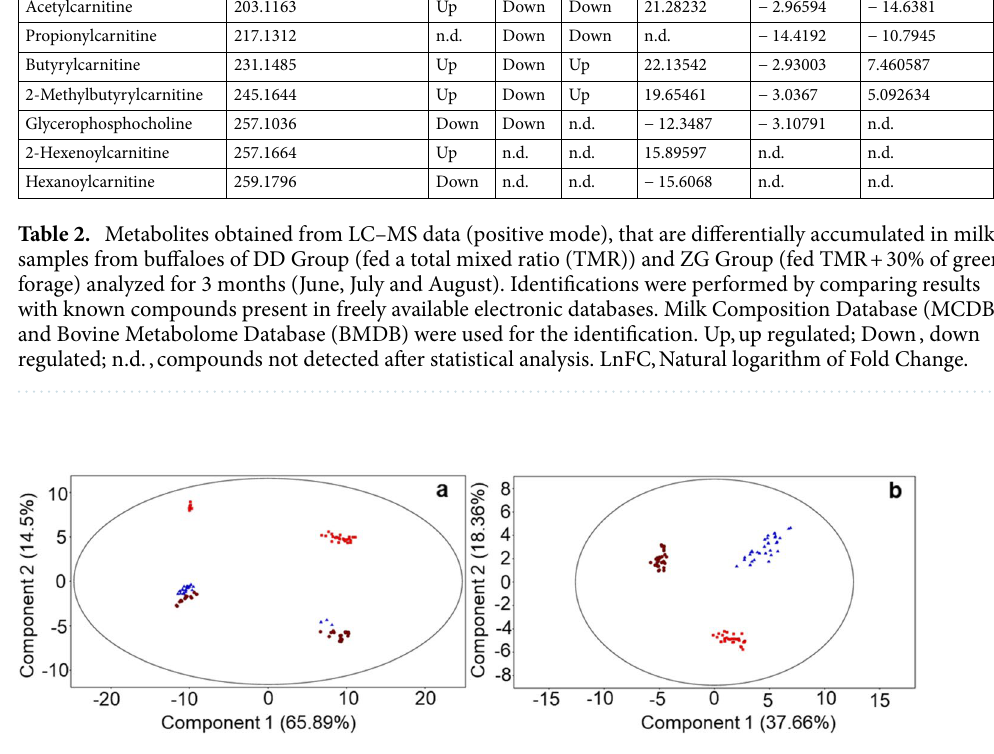
Figure 2. PCA score plots of the LC–MS data acquired for milk samples collected in June (brown circles), July (blue triangles) and August (red squares) from buffaloes DD Group fed a total mixed ratio (TMR) and ZG Group fed TMR + 30% of green forage. ( A ) DD Group: PC1 accounts for 65.89% and PC2 14.5% of total variance; ( B ) ZG Group: PC1 variance 37.66% and PC2 variance